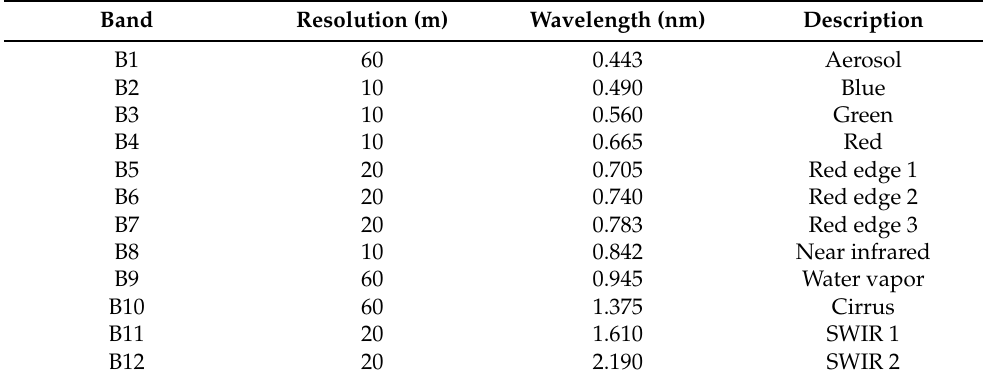
Table 1. Characteristics of S2 bands